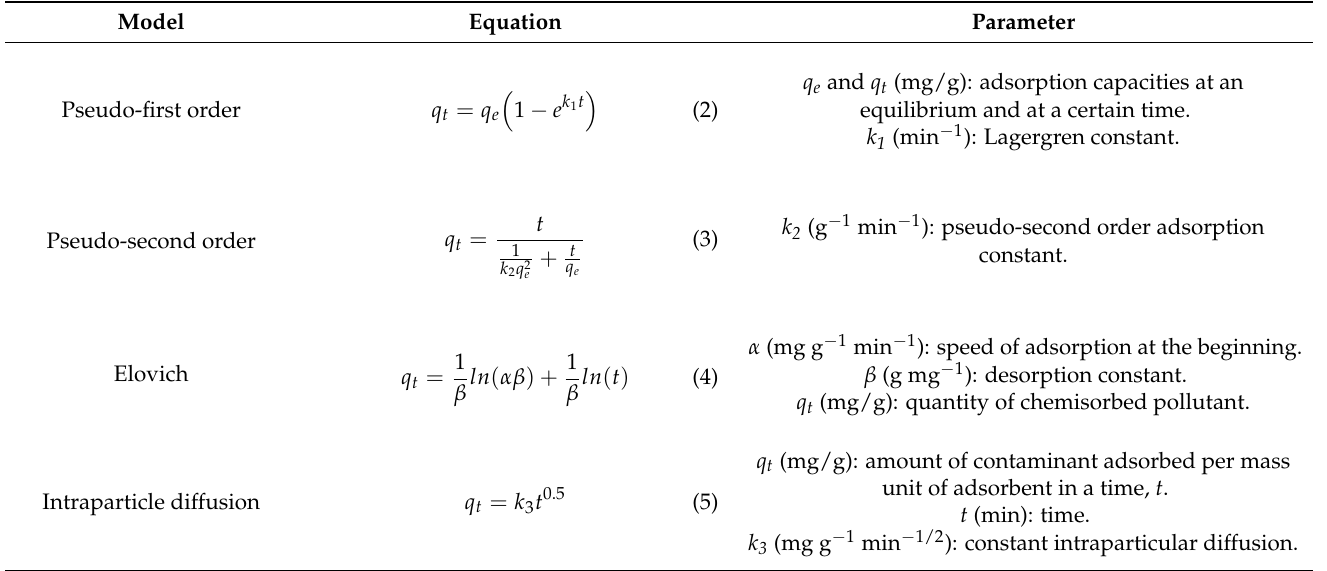
Table 1. Non-linear kinetic